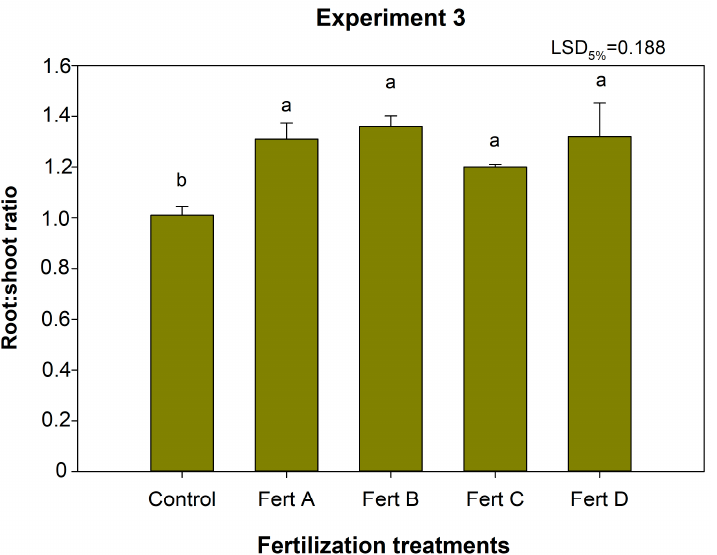
Figure 12. Root:shoot ratio of bristly oxtongue as affected by various fertilization regimes. For each sampling date, bars followed by the same letters were not shown to significantly differ with Fisher’s least significant difference (LSD) test. The error bars show the Standard Error values. Final measurement (source of variation: treatments): Fvalue = 6.092, p = 0.015, DF (degrees of freedom) = 4.